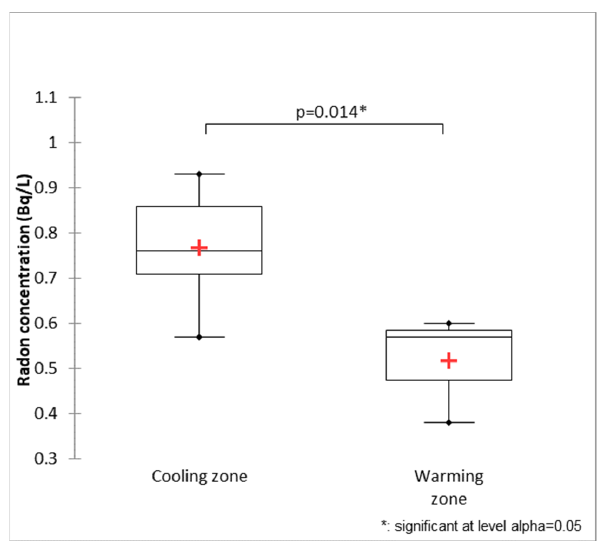
Figure 10. Box and whisker plot of radon concentration for cooling and warming zones of Berard River showing significant difference at 95% confidence level t-test.